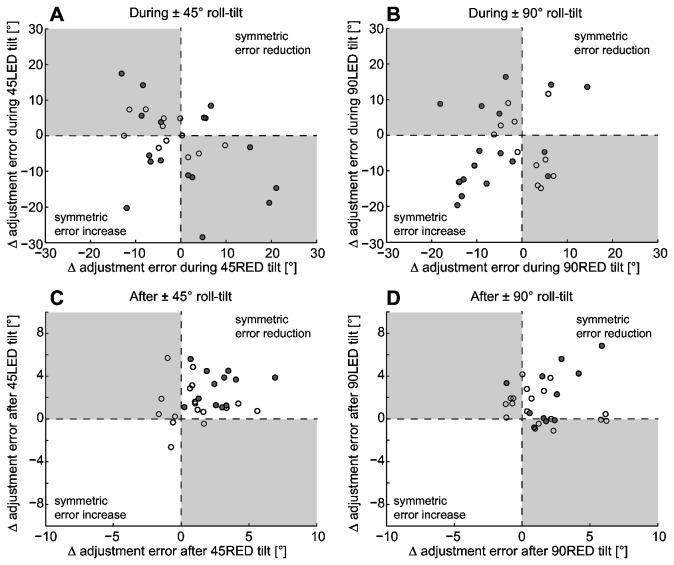
Comparison of changes in adjustment errors over the 5-minute recording periods during (panels A and B) and immediately after (panels C and D) prolonged roll-tilt (±45° or ±90°).Grey filled circles refer to runs with significant drift for both RED and LED while empty circles indicate runs with non-significant drift in at least one of the two conditions. Each panel is split up in 4 areas separated by dashed horizontal and vertical lines along zero: while the grey-shaded areas indicate runs where drift was not symmetric (e.g. error was increasing at 45° RED and decreasing at 45°LED or vice versa), trials with symmetric drift for LED and RED (for a given roll angle) will fall in the white areas, either in the lower left corner (if adjustment errors increased over time) or in the upper right corner (if adjustment errors decreased over time).